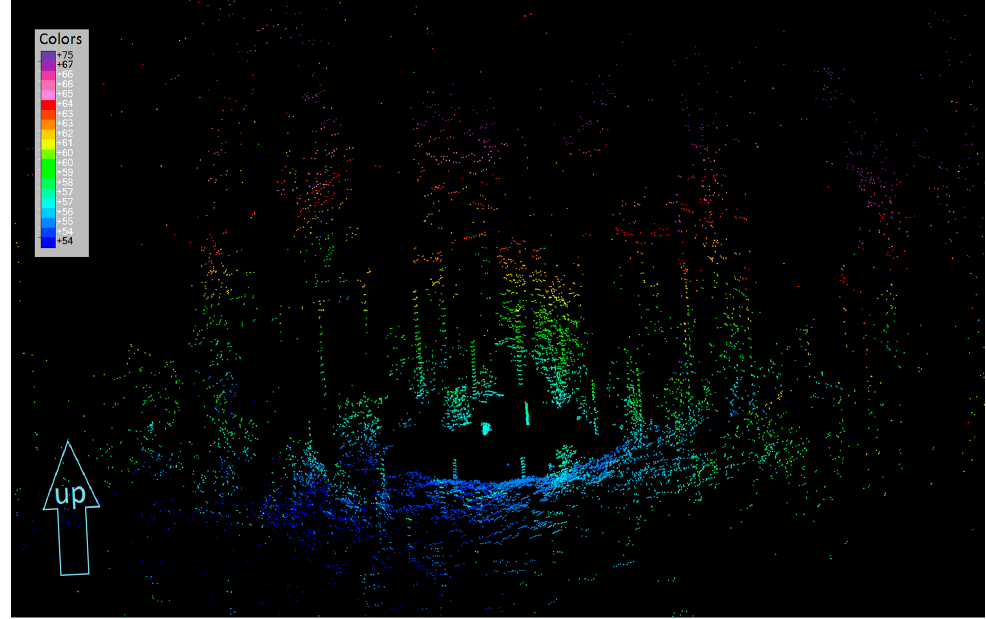
Figure 3. Approximately 10,000 laser points are collected during one scan rotation. Figure 3 shows an example of one scan rotation from an oblique perspective where the points are colored by